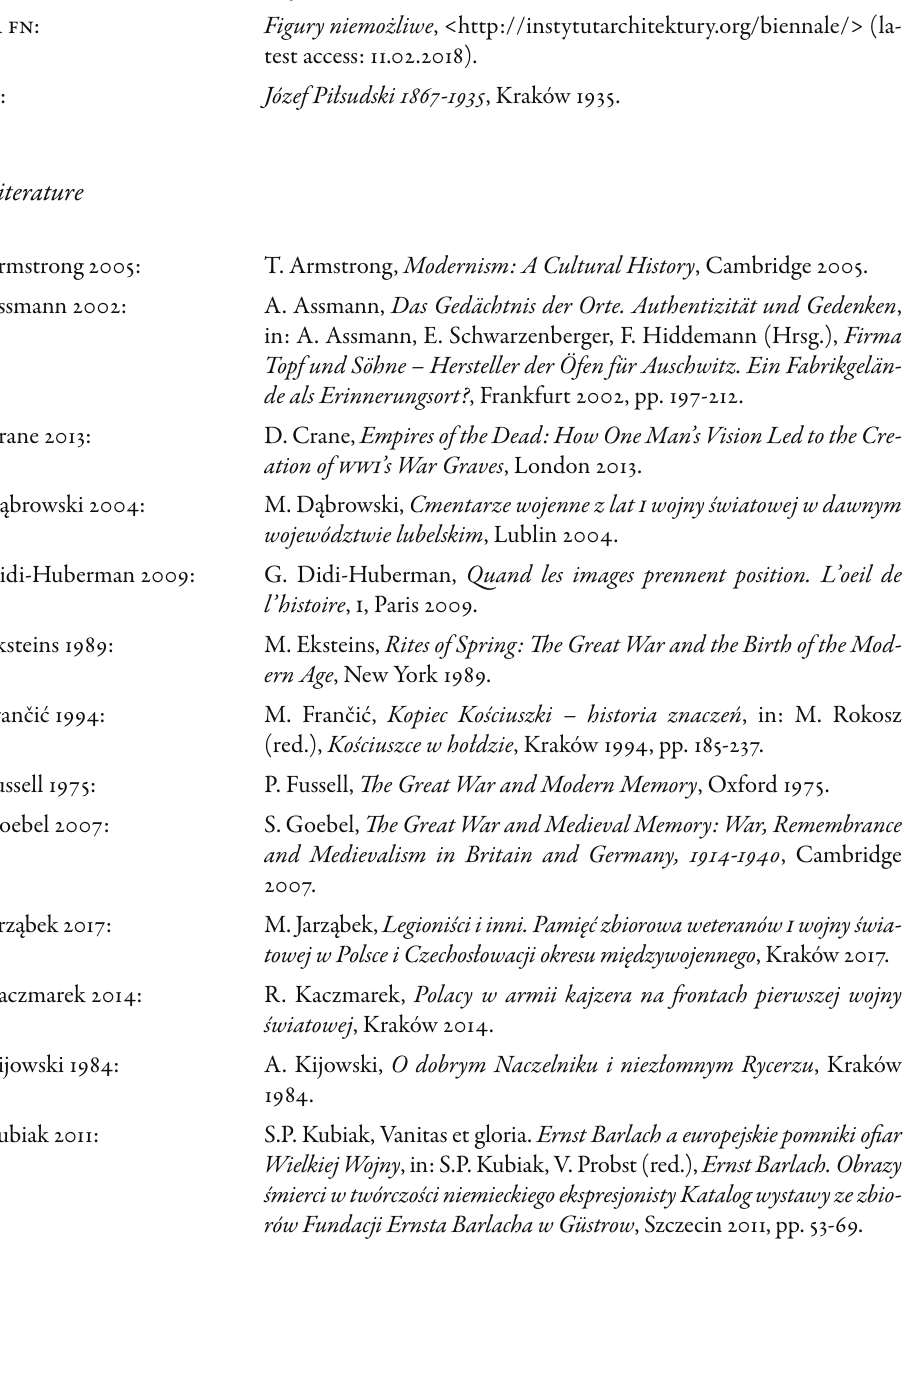
Figury niemożliwe , <http://instytutarchitektury.org/biennale/> (la- test access: